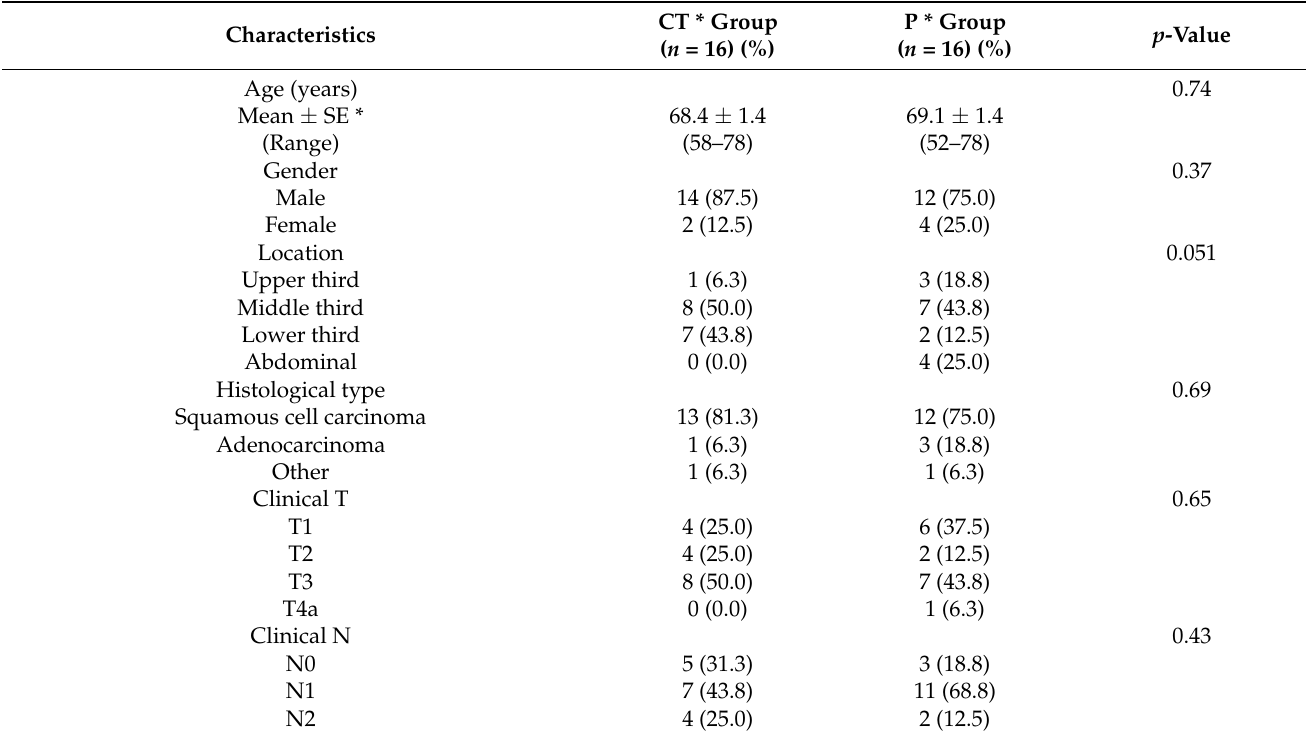
Figure 1. The CONSORT flowchart showing the randomization of patients in the study. Table 1. Comparison of the baseline characteristics of the patients in the CT and placebo groups.